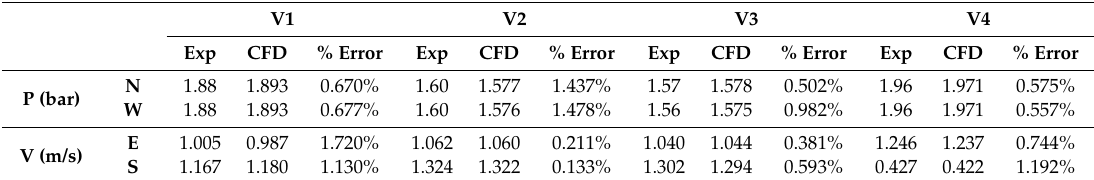
Table 3. Approximation errors between experimental and simulated tests.